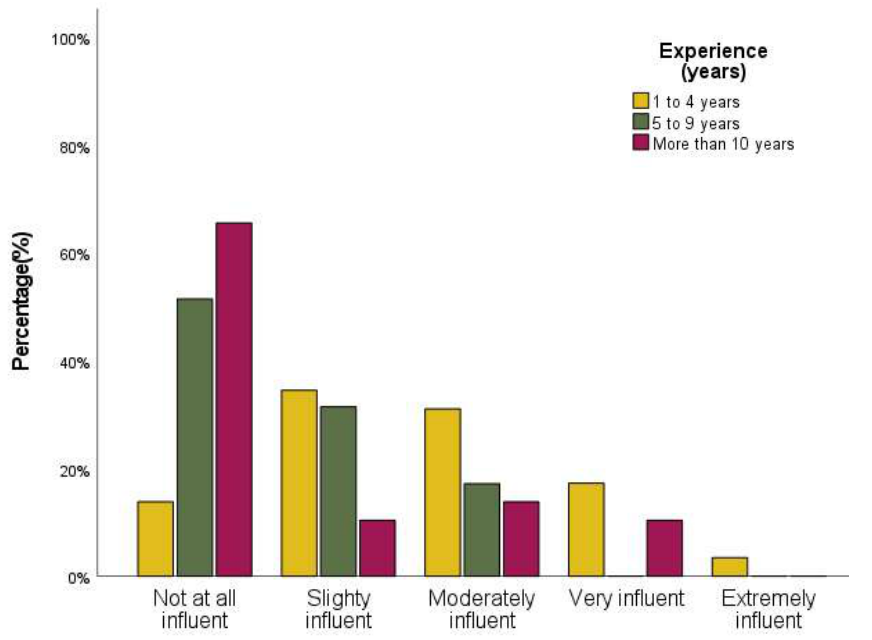
Figure 2. Bar graph showing self-perceived supervisor’s influence on decision-making according to experience (years).